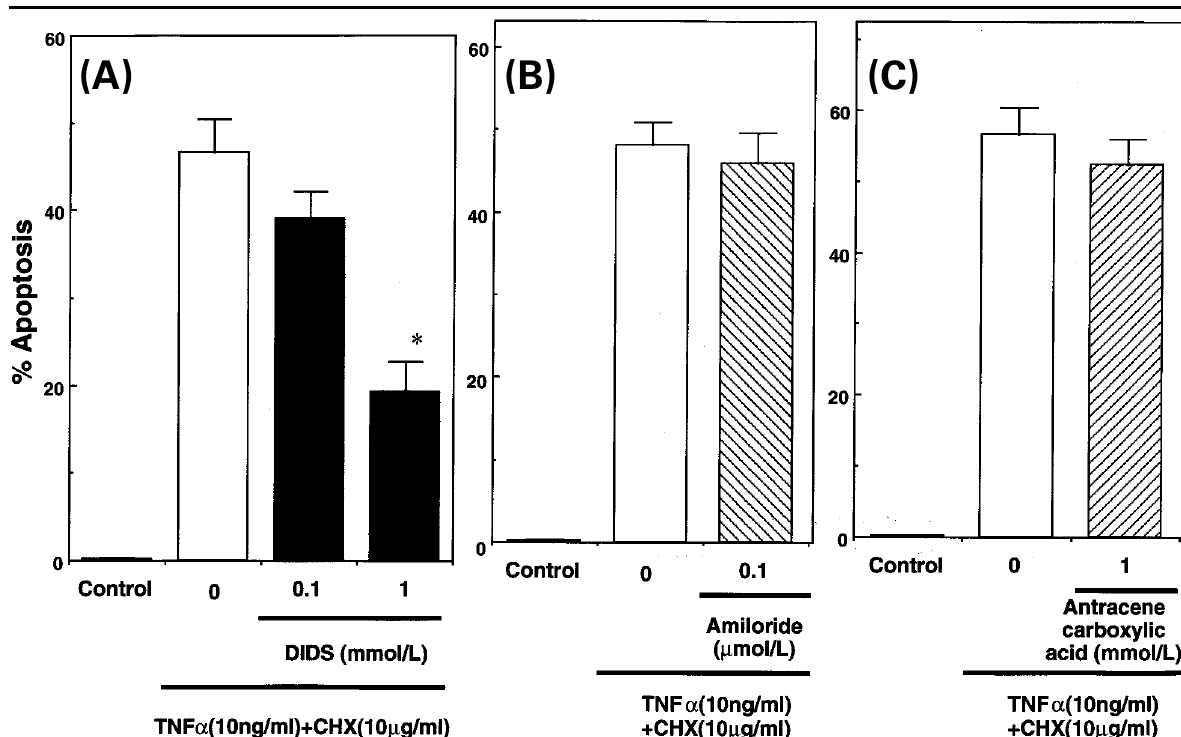
FIG. 5. Effects of various ion transporter inhibitors on TNF a and cycloheximide-induced apoptosis of endothelial cells. (A) Endothelial cells were treated with TNF a (10ng/ml) and cycloheximide (10 m g/ml) in the presence of various concentrations of DIDS (0.1–1mmol/l) for 6h. After the incubation treatment, the cells were stained with propidium iodide, as described in Materials and methods. The percentage of apoptotic endothelial cells represents the number of apoptotic cells in the counted 100 cells (viable cells+apoptotic cells). The data show the mean±SEM for 10 wells. * P <0.05 versus TNF a and cycloheximide- treated group. Each experiment was repeated three times. (B) Endothelial cell monolayers were treated with TNF a (10ng/ml) and cycloheximide (10 m g/ml) in the presence of dimethyl amiloride (0.1 m mol/l) for 6h. After the incubation treatment, the cells were stained with PI, as described in Materials and methods. Each experiment was repeated three times. (C) Endothelial cell monolayers were treated with TNF a (10ng/ml) and cycloheximide (10 m g/ml) in the presence of anthracene carboxylic acid (1 m mol/l) for 6h. After the incubation treatment, the cells were stained with PI, as described in Materials and methods. Each experiment was repeated three